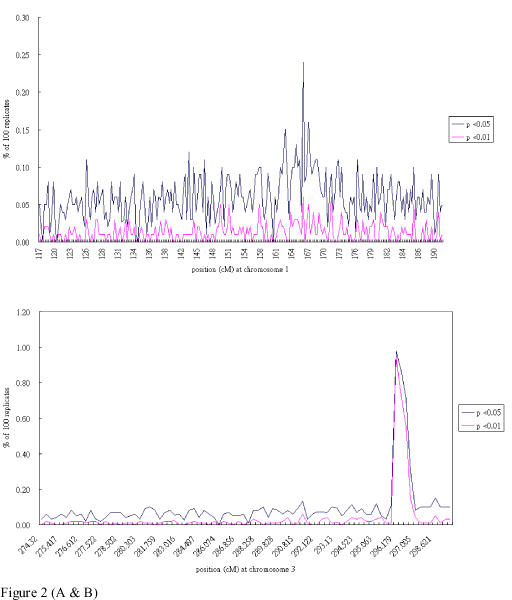
Proportion of 100 replicates showing significant p-value in each SNP at chromosome 1 (A) chromosome 3 (B).